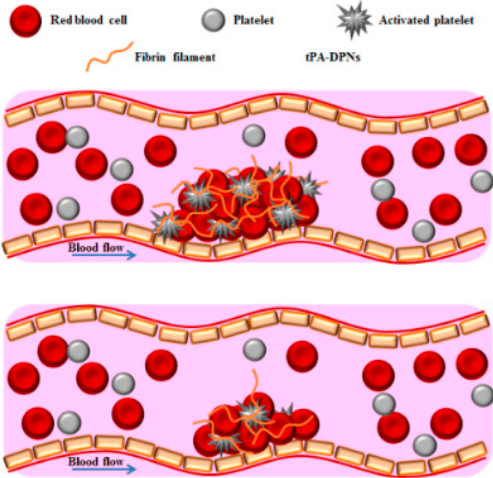
Figure 1. Schematic representation of the action of tPA-DPNs on a blood clot.